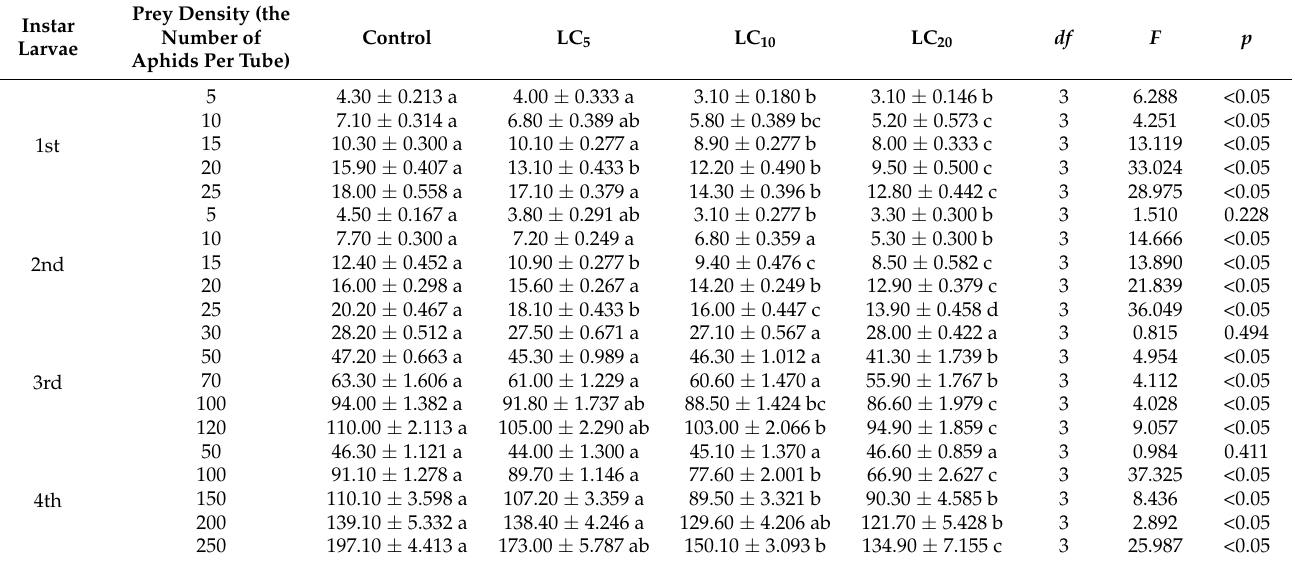
Table 2. The amount of prey consumed by each instar larvae of C. septempunctata treated with the acetamiprid sublethal concentration for 24 h (Mean ±